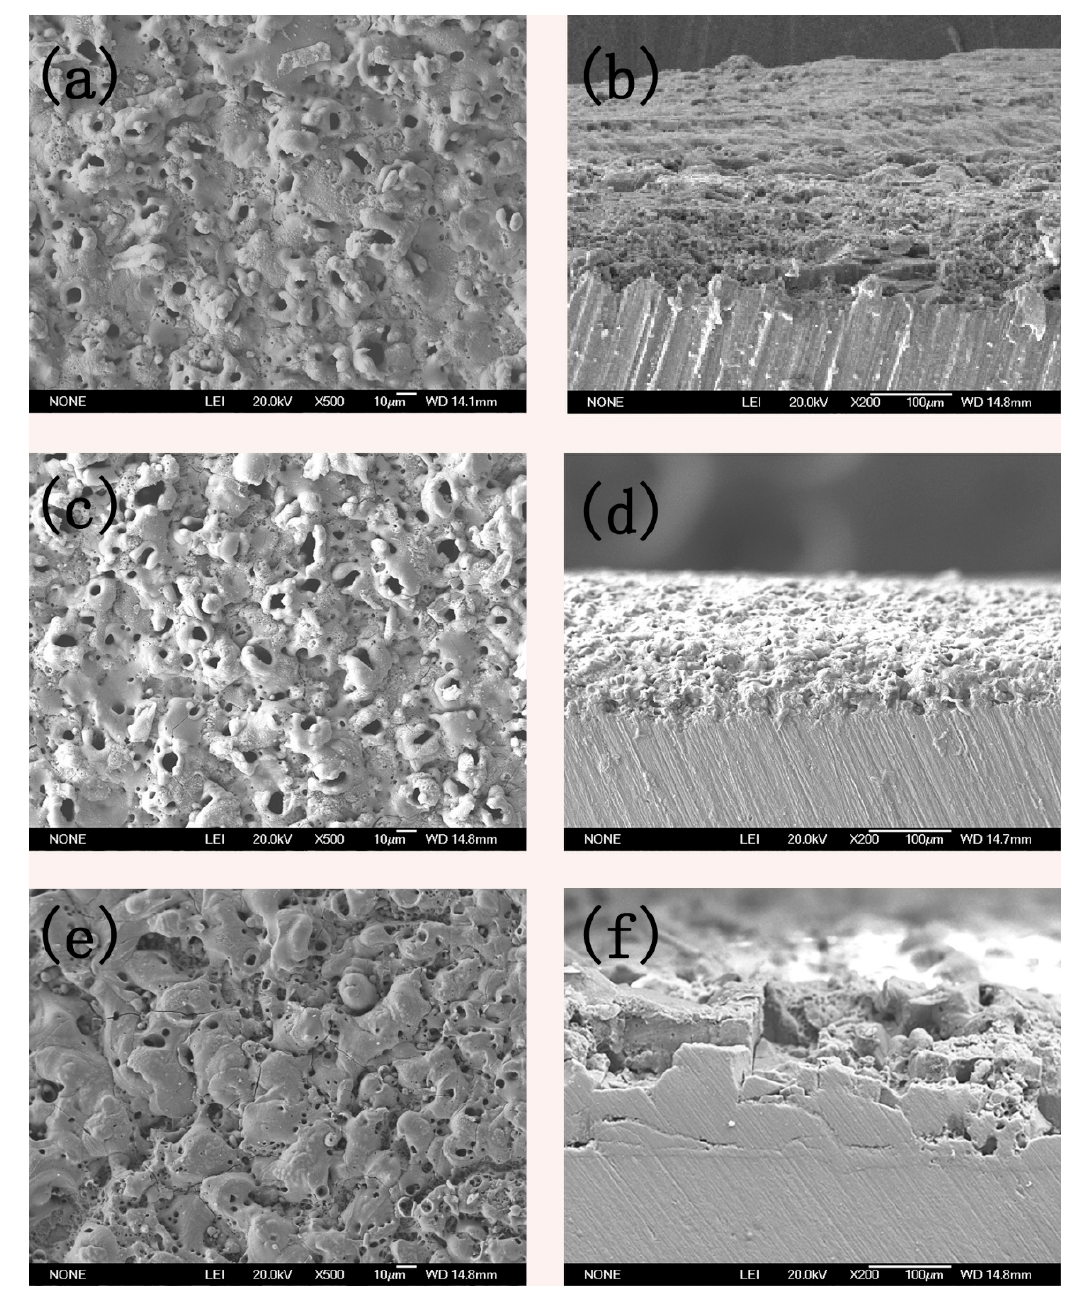
Figure 8. Micro-morphology ( a , c , e ) and cross section ( b , d , f ) of APD coating at duty cycle of 10 % ( a , b ), 15 % ( c , d ) and 20 % ( e , f ).